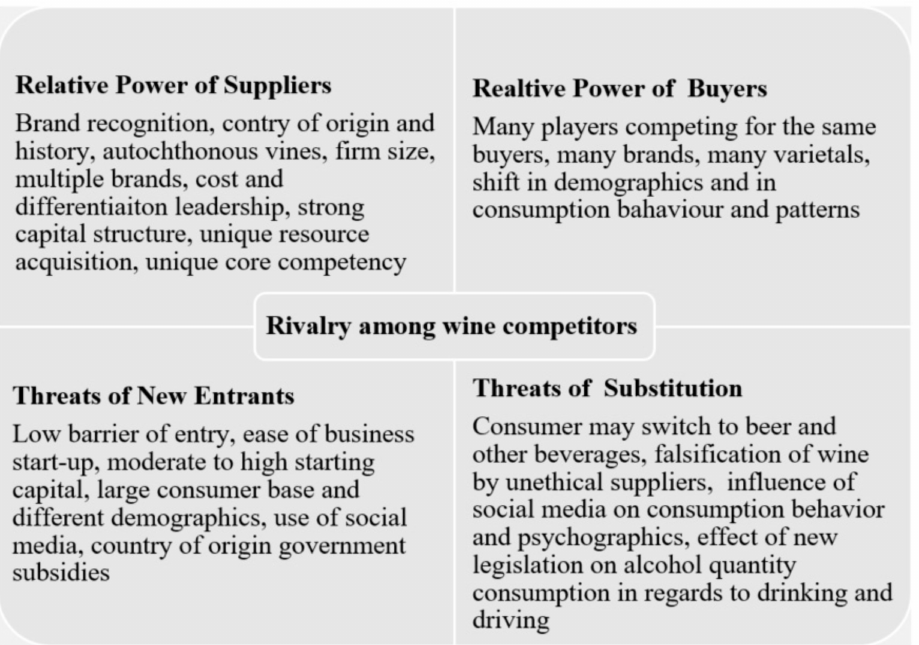
Figure 5. Sample Porter’s five forces model applied to the wine trade. Source: Authors’ synthesis from literature review